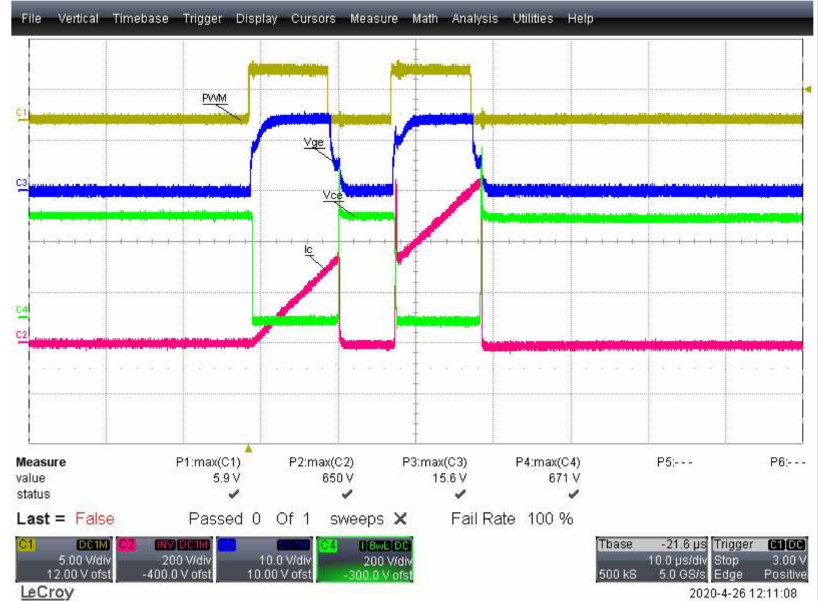
Figure 6. IGBT double pulse test waveform.